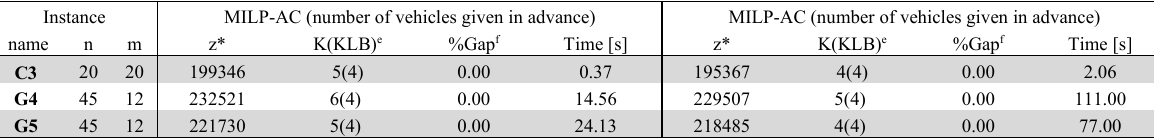
Examples of results minimizing the number of